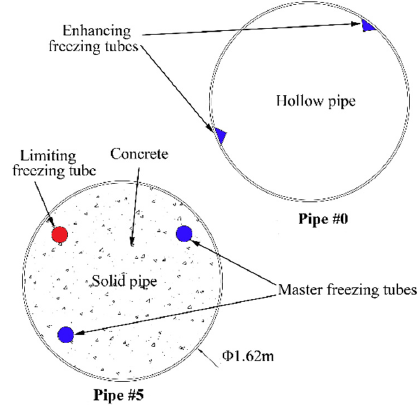
Figure 6. The arrangement of freezing tubes in the test Figure 6 . The arrangement of freezing tubes in the test pipes. Figure 6 . The arrangement of freezing tubes in the test pipes.